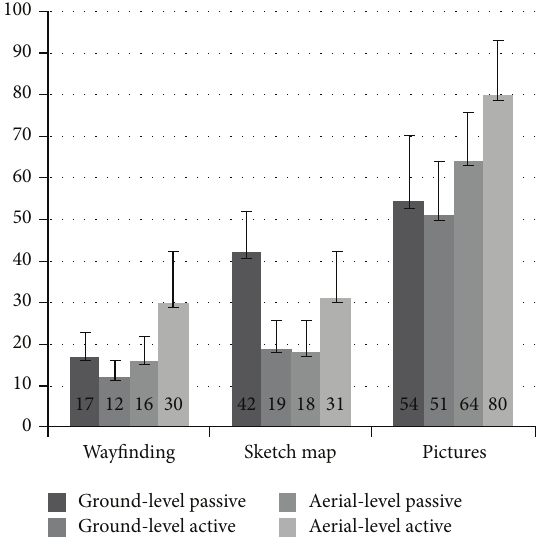
Figure 3: Means of errors (%) for each recall task as a function of the Viewpoint and Navigation